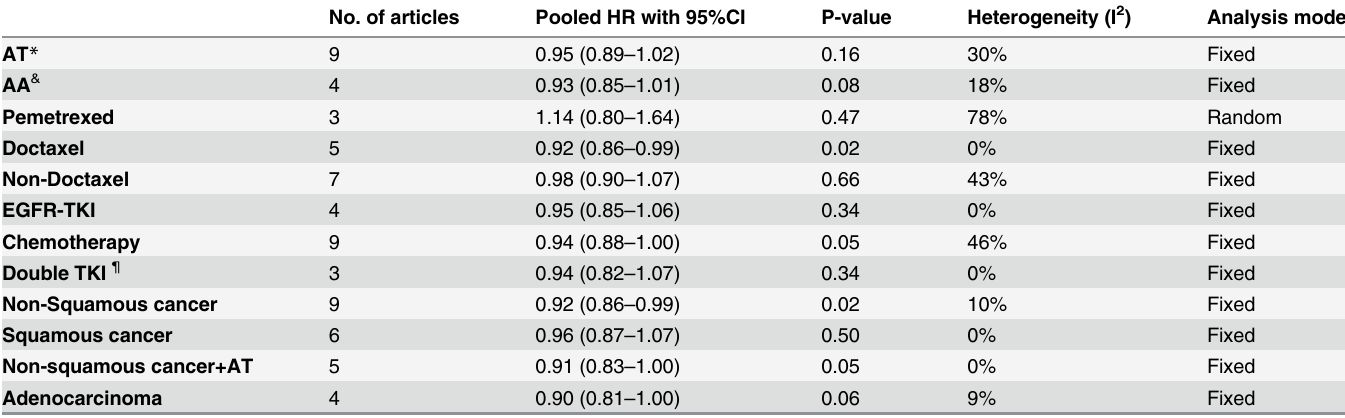
Table 3. Summary of the subgroup results: Pooled HR & 95%CI for